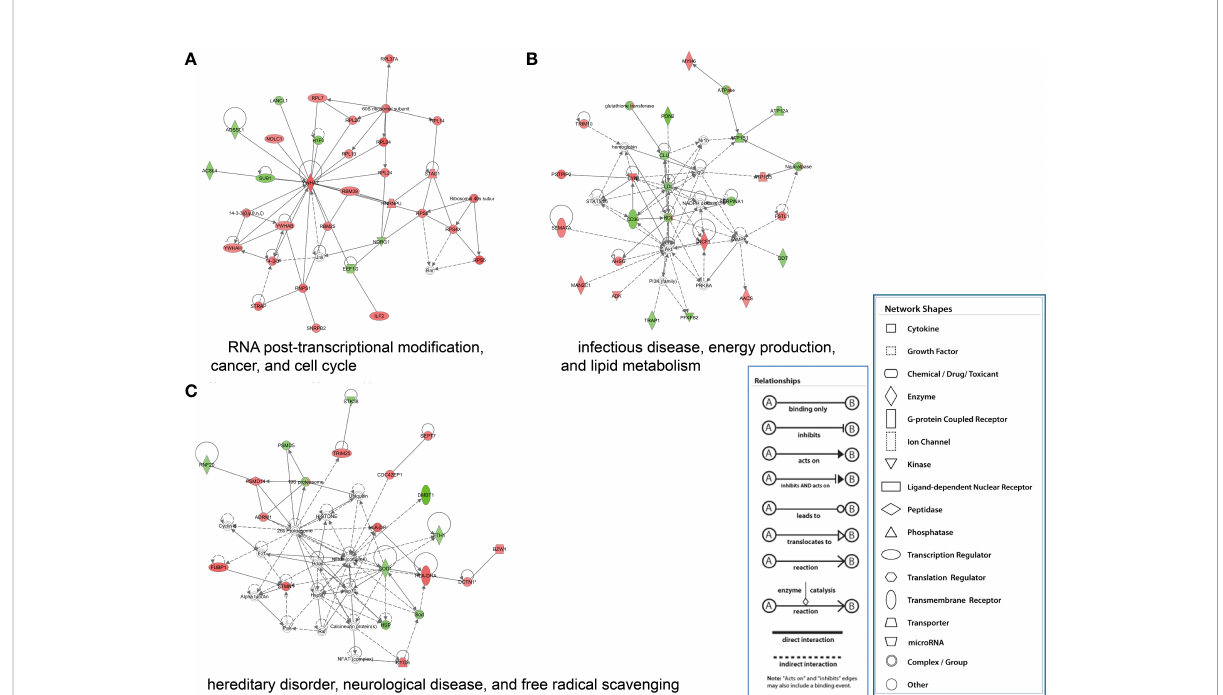
FIGURE 5 IPA of proteins that were signi fi cantly altered to construct speci fi c functional networks. Red, up-regulated proteins; green, down-regulated proteins; white, proteins known to be in the Ingenuity Pathways Knowledge Base but were not identi fi ed in this study. The color depth indicates the magnitude of the change in protein expression level. The shapes indicate the molecular class (i.e., protein family). Lines connecting the molecules imply molecular relationships. Dashed lines indicate indirect interactions, and solid lines indicate direct interactions. The arrow styles mean speci fi c molecular relationships and the directionality of the interaction. (A) RNA posttranscriptional modi fi cation, cancer, and cell cycle; (B) infectious disease, energy production, and lipid metabolism; (C) hereditary disorder, neurological disease, and free radical scavenging.